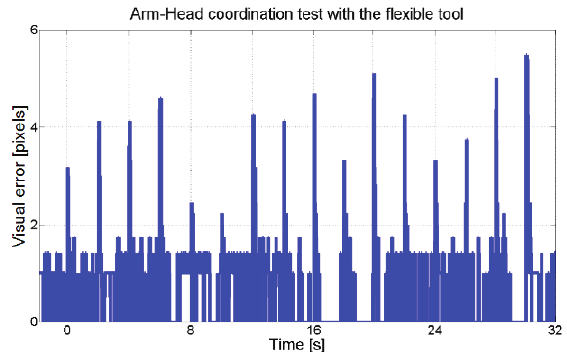
Figure 18. End-e(cid:636)ectorvisualpositionerrorwithrespecttotimeduringthearm- head coordination test performed with the tool. The norm of the